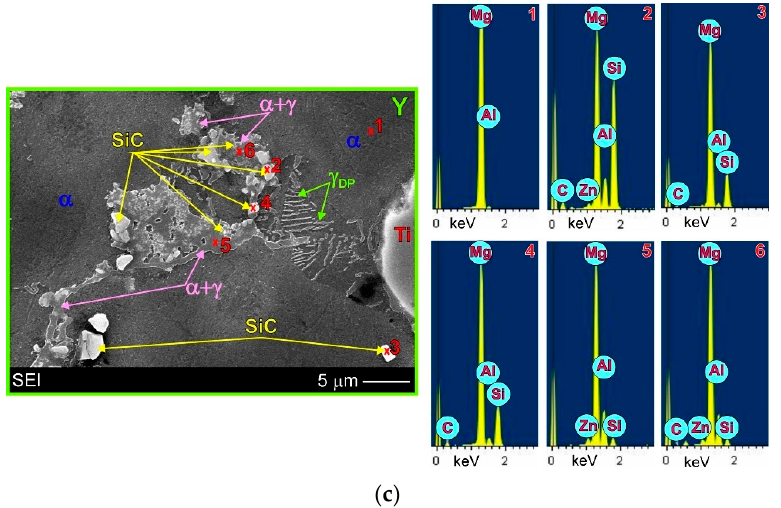
Figure 8. Microstructure of AZ91/(SiC + Ti) p hybrid composite: ( a ) SEM micrograph; ( b ) Higher magnification of area marked as X on ( a ) micrograph with EDX results in form of X-ray spectrums from designated points; ( c ) Higher magnification of area marked as Y on ( a ) micrograph with EDX results in form of X-ray spectrums from designated points.